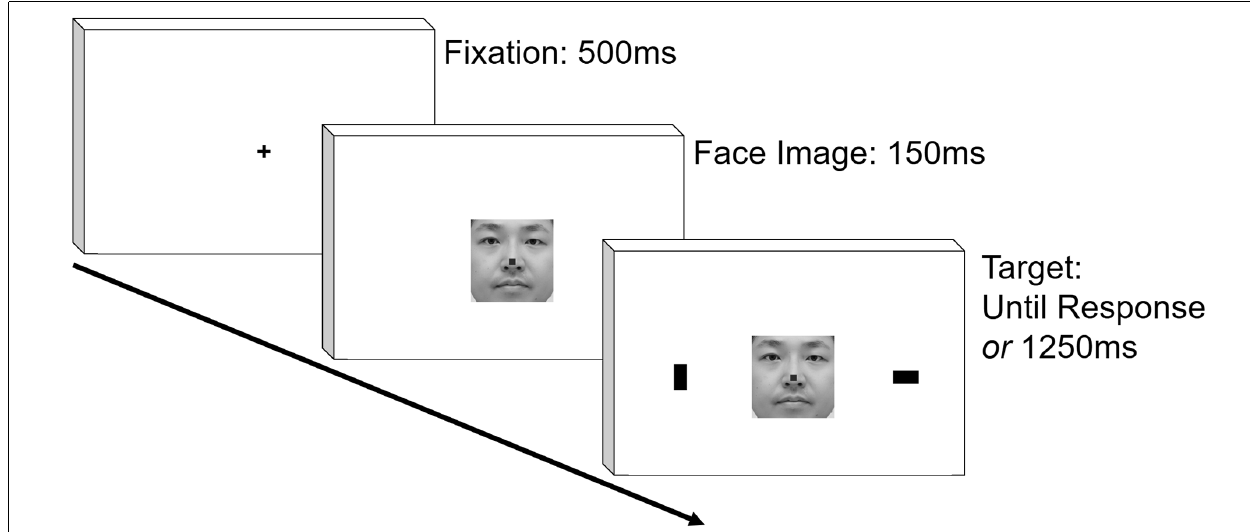
FIGURE 1 | Schematic representation of temporal sequence in stimulus presentation. The face image is not exactly the same with those presented in the actual experiment.